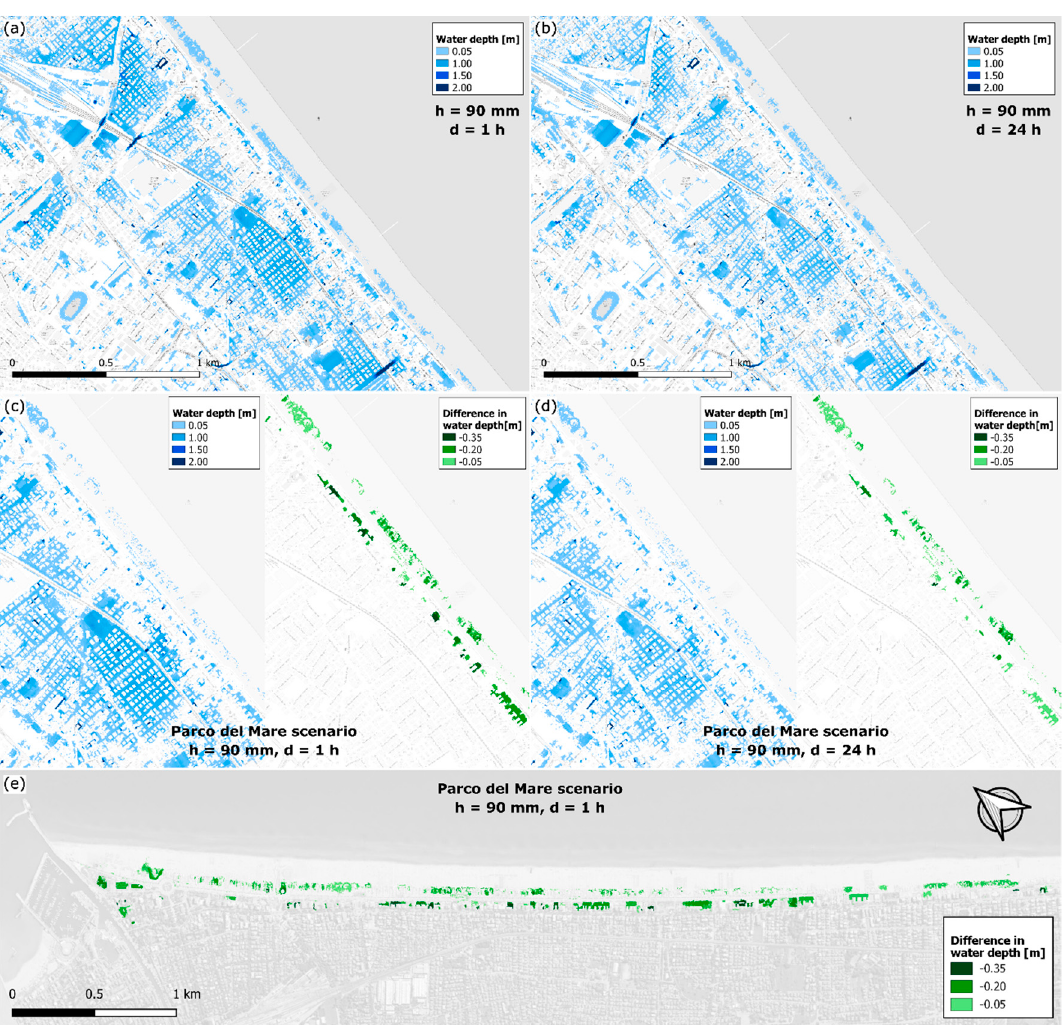
Figure 10. Rimini case study: water depth maps simulated with Safer_RAIN for the two considered synthetic events (see also Figure 9): 1-h ( a ) and 24-h ( b ) rainfall events for the current land-use scenario; ( c , d ) simulated water depth for the 1-h ( c ) and 24-h ( d ) rainfall events and the Parco del Mare land-use scenario (urban green-infrastructure, left) and differences in water depth compared to the current layout (right); ( e ) 90 mm 1-h rainfall event, simulated water depth for the Parco del Mare urban green infrastructure minus the simulated water depth for the current land-use scenario along the seafront.